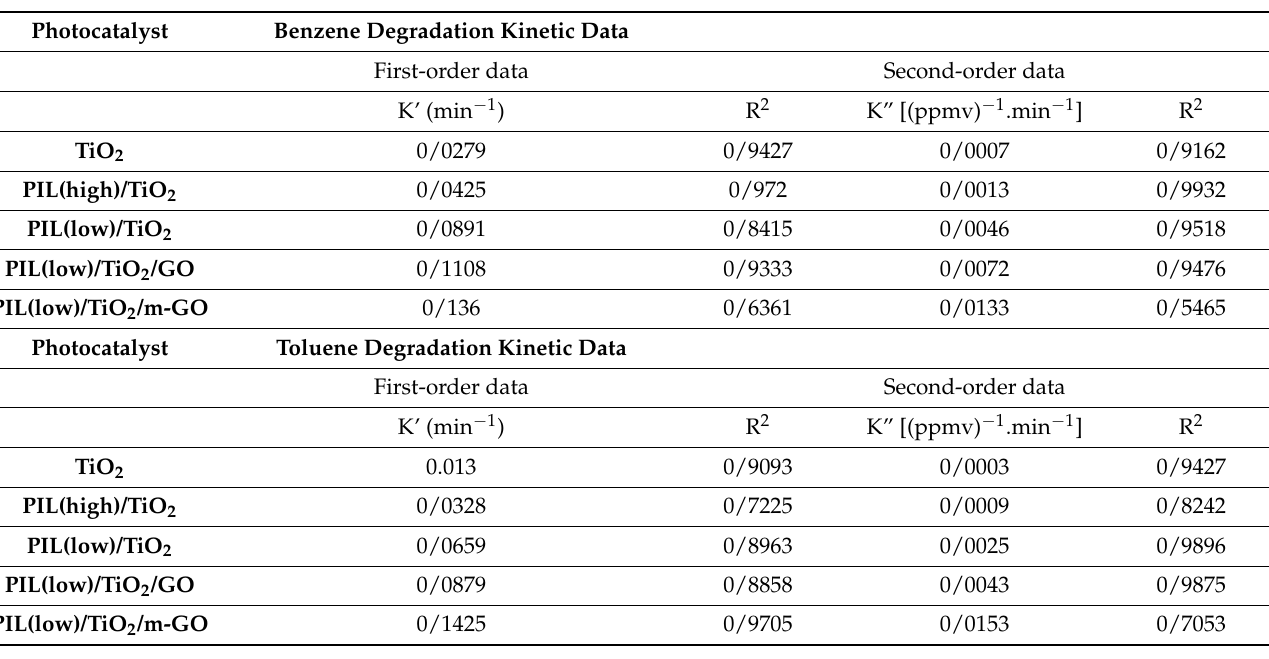
Table 3. The kinetic data for benzene and toluene